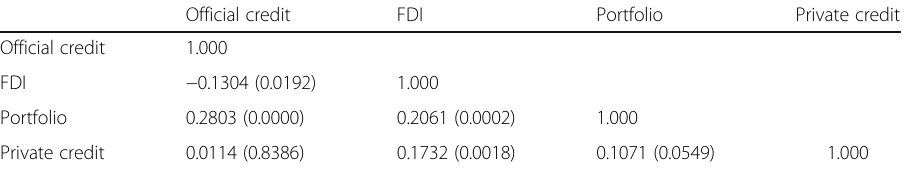
Table 14 Correlation test for Foreign Capital Inflows components